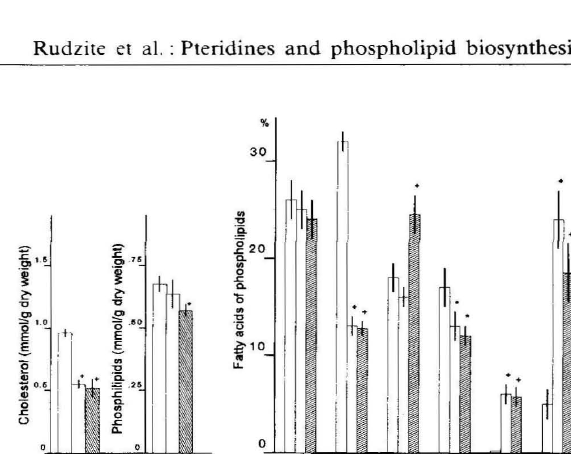
Figure 1. Concentrations (mean ± S.D.) of cholesterol and phospholipids, as well as fatty acid content (in percent: mean ± S.D.) of phospholipids in controls (open bars) and in samples with 5 pmol/g wet weight (dotted bars) or with 30 pmol/g wet weight (hatched bars) sepiapterin. Samples of rat liver tissue homogenates were used to test for phospho lipid biosynthesis in vitro.' Incubation medium: Krebs-Rin ger-phosphate buffer (pH=7.4), fatty acid mixture and gly cerol. Samples were incubated twice for 4 h at 37°C. *The changes are statistically significant (p<0.05). tThe changes are statistically significant